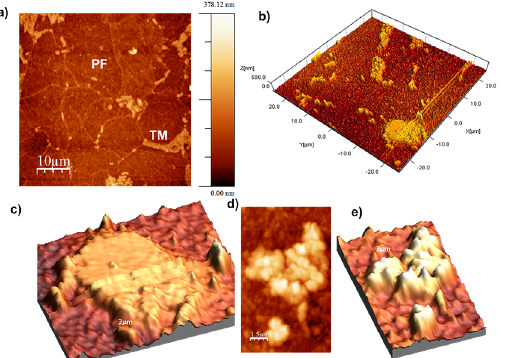
Figure 4. AFM image of a) IZ, b) 3D image of micrograph c) bainite 3D image, d) and e) martensite